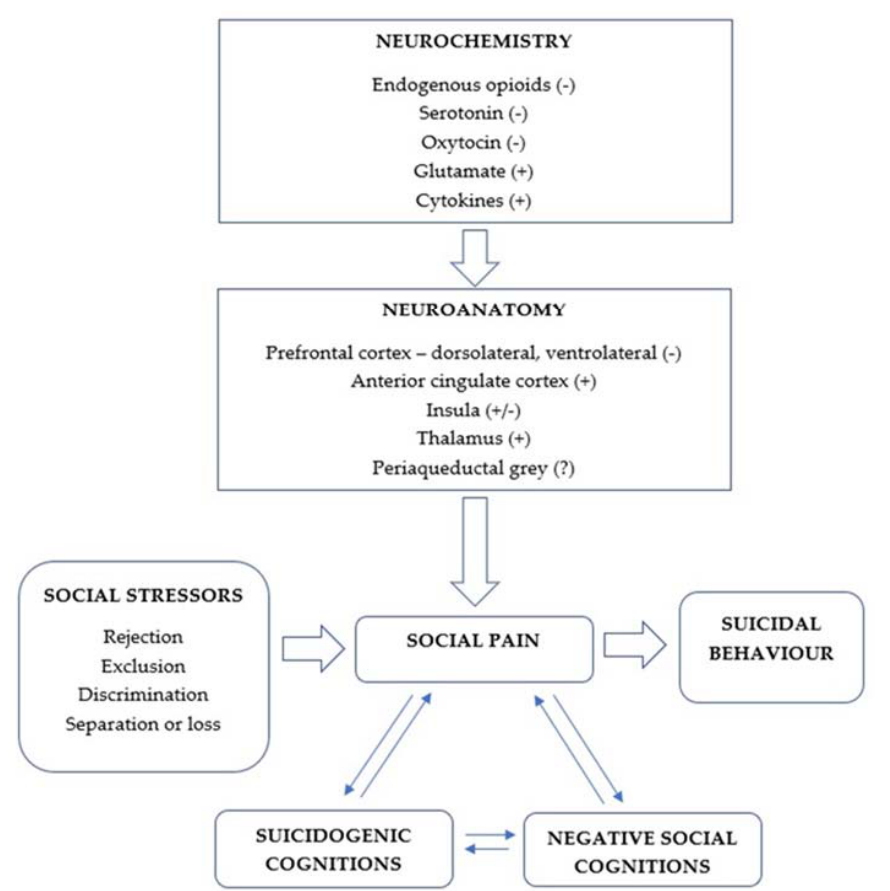
Figure 1. The social pain model of suicide and its biological substrates. (+) indicates a transmitter or region that may be associated with an increase in social pain; ( − ) indicates a transmitter or region that may attenuate social pain; (+/ − ) indicates evidence of mixed effects; (?) indicates an uncertain effect.